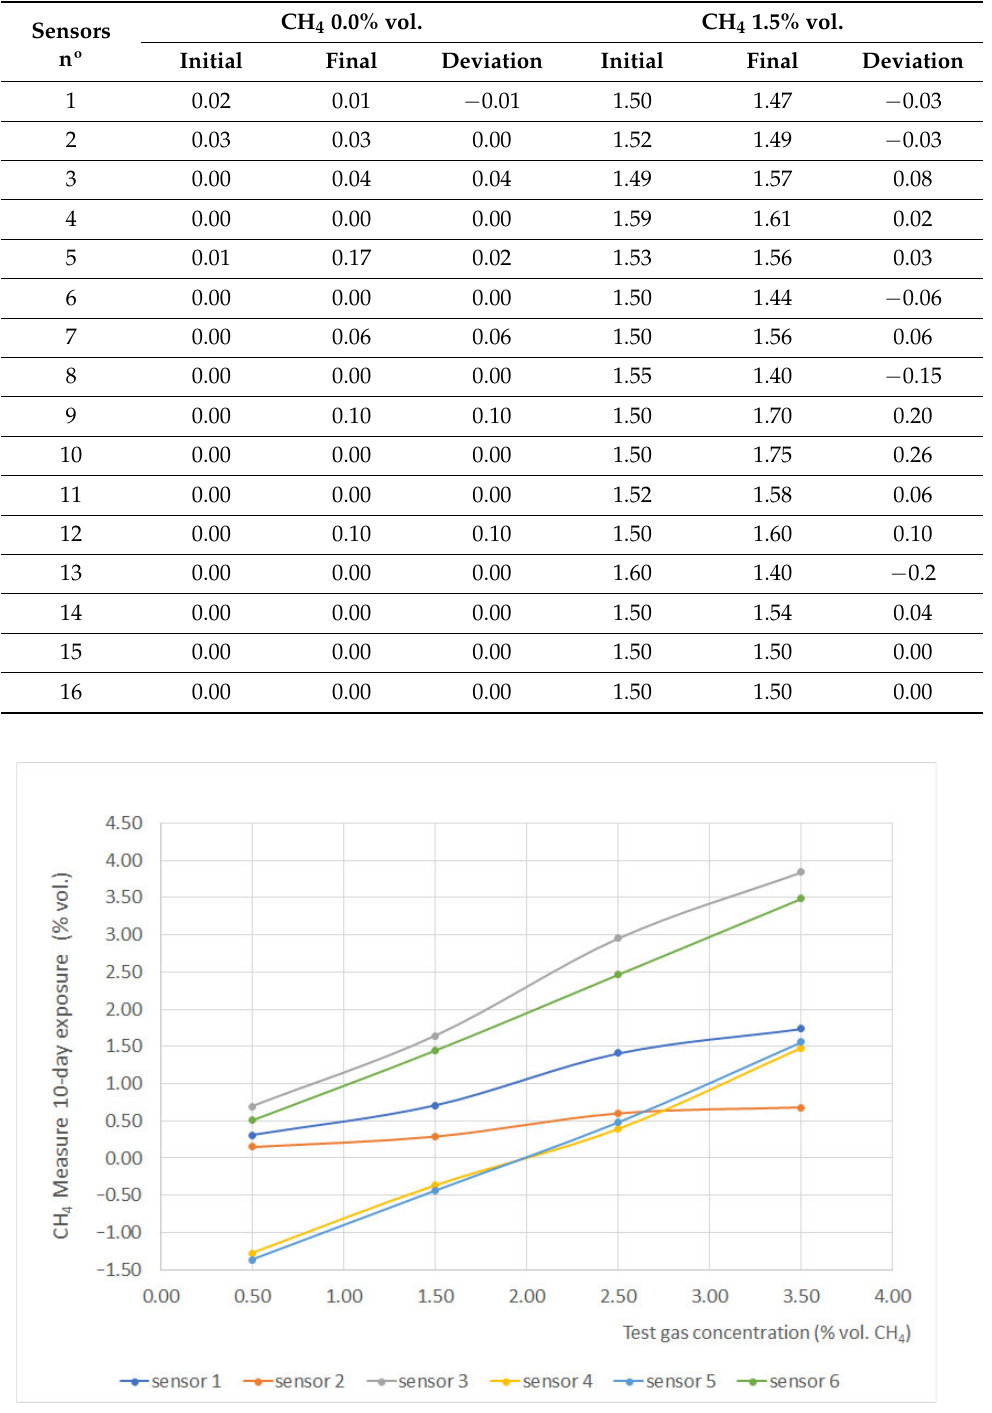
Figure 11. Long term stability results.